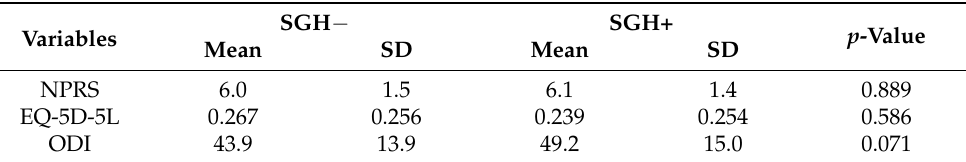
Table 3. Comparison of patients’ key medical assessment tools according to the Social Gradient of Health